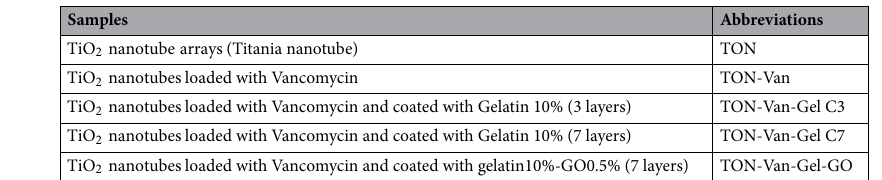
Table 2. Samples and related